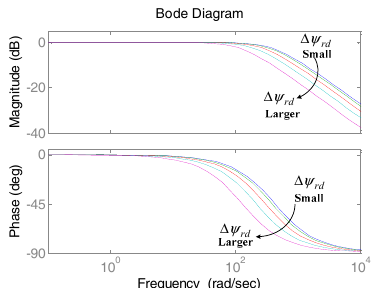
Figure 2. Variation bode diagram of ω / ω ref to ∆ ψ rd .